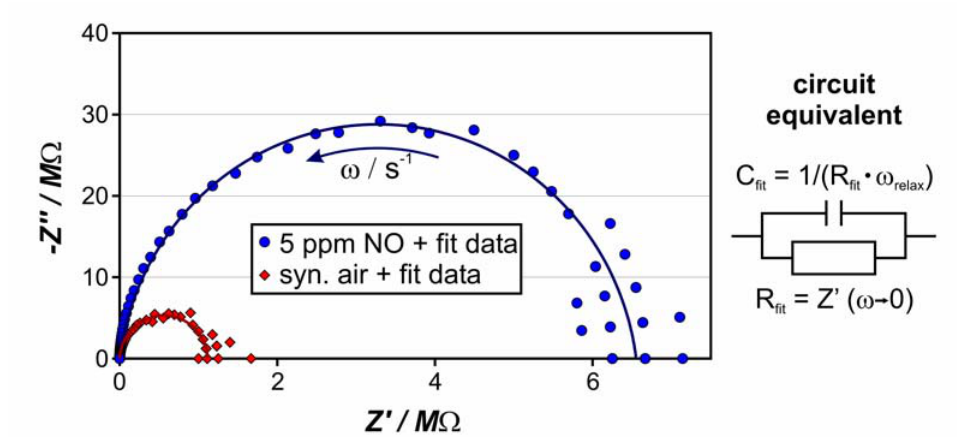
Figure 4. Argand plot and circuit equivalent of Ir@ZnO under synthetic air and NO. Ir@ZnO shows an increase of resistance compared to synthetic air, when NO is admixed (T=250 °C).